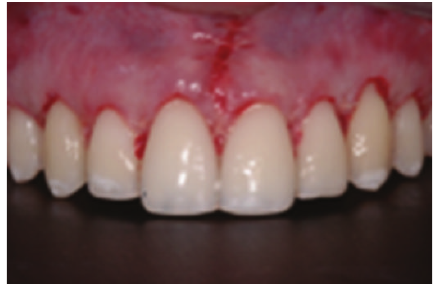
Figure 12: Flaps are sutured in apical position at CEJ.